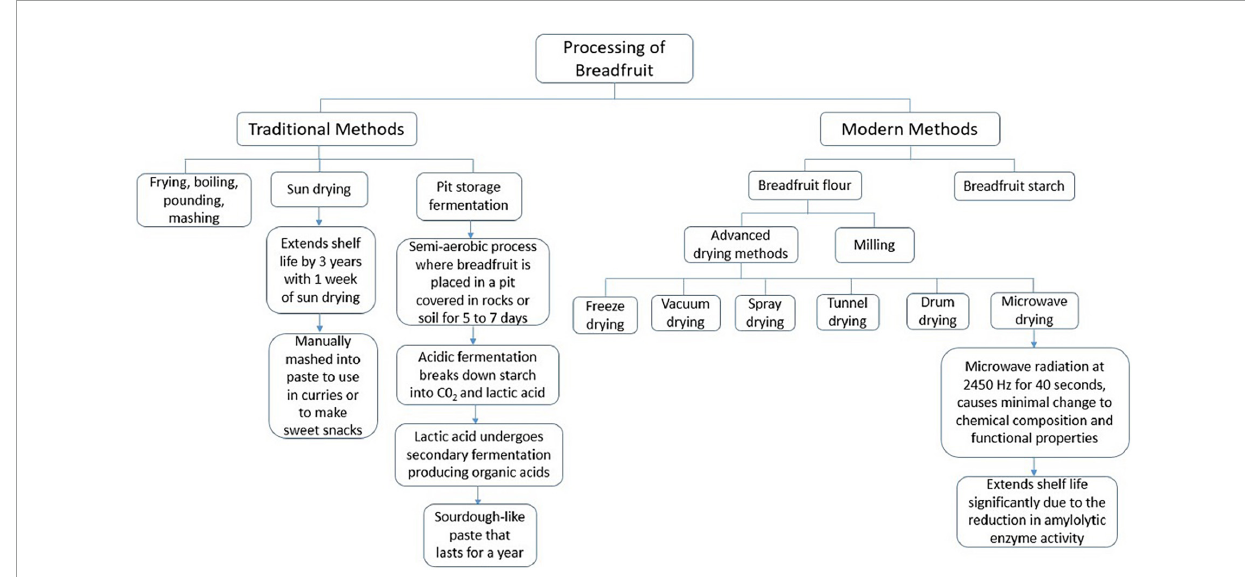
FIGURE1 Traditional and modern methods for processing breadfruit